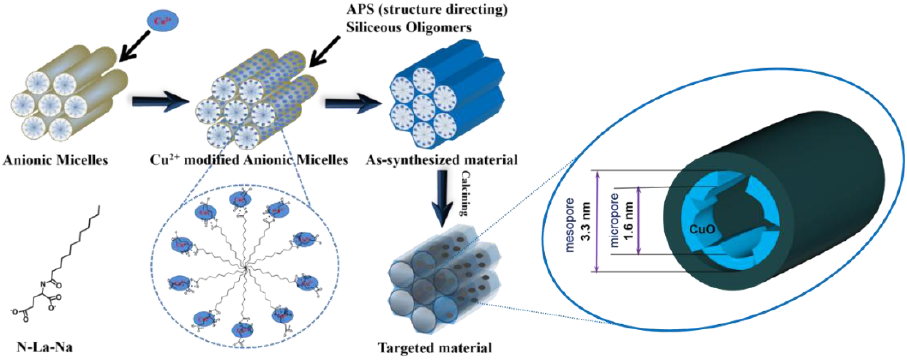
Figure 13. The tailored pore channels in CuO-based mesoporous silica through the anionic template- induced method.